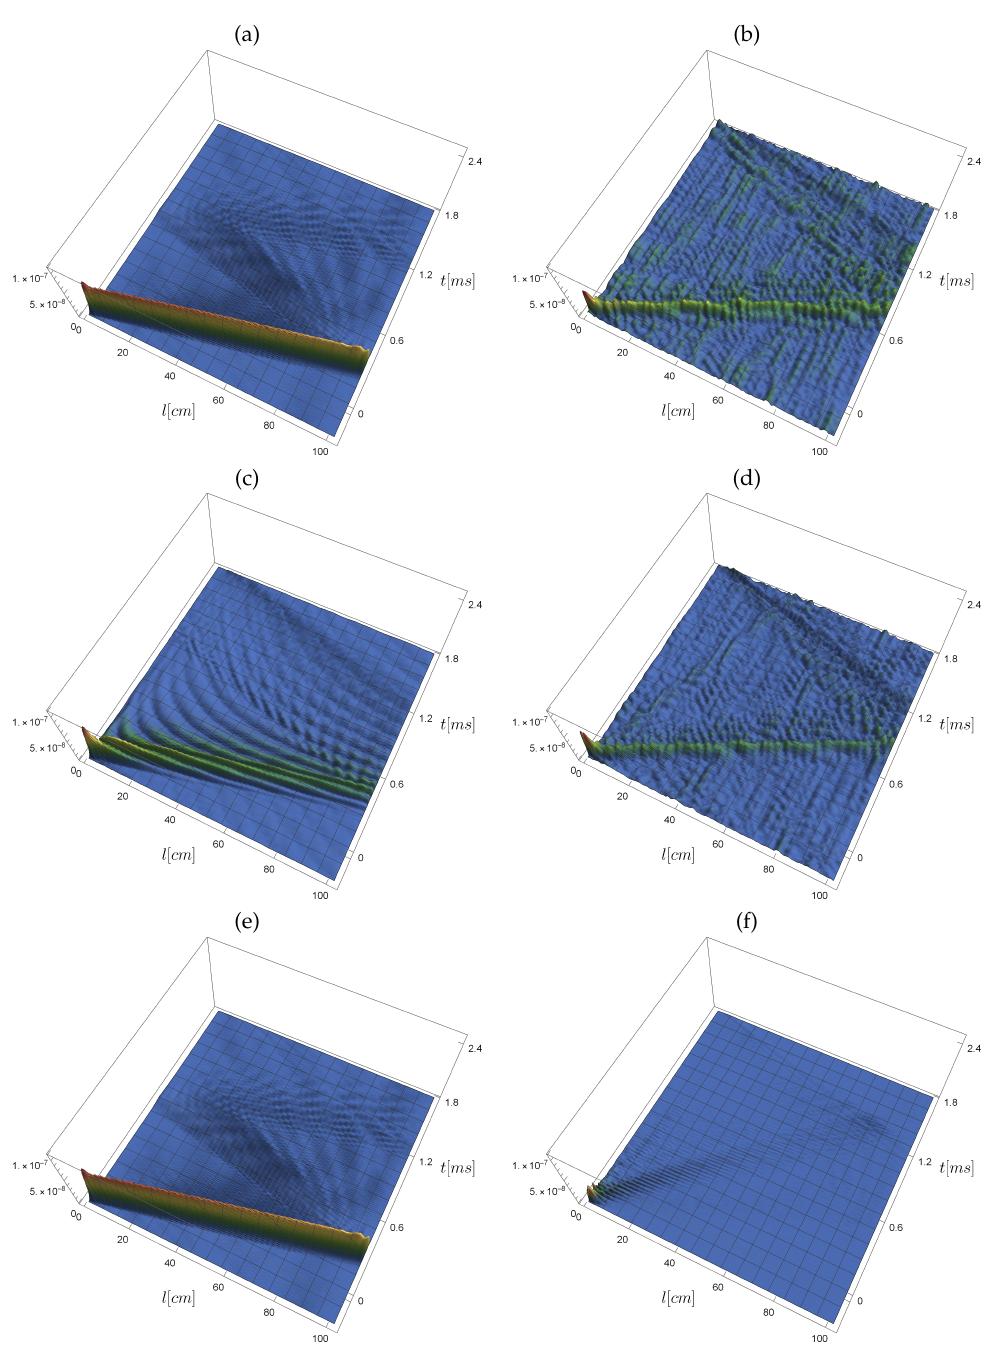
Figure 9. Patterns of flexural wave propagation in an electromechanical periodic